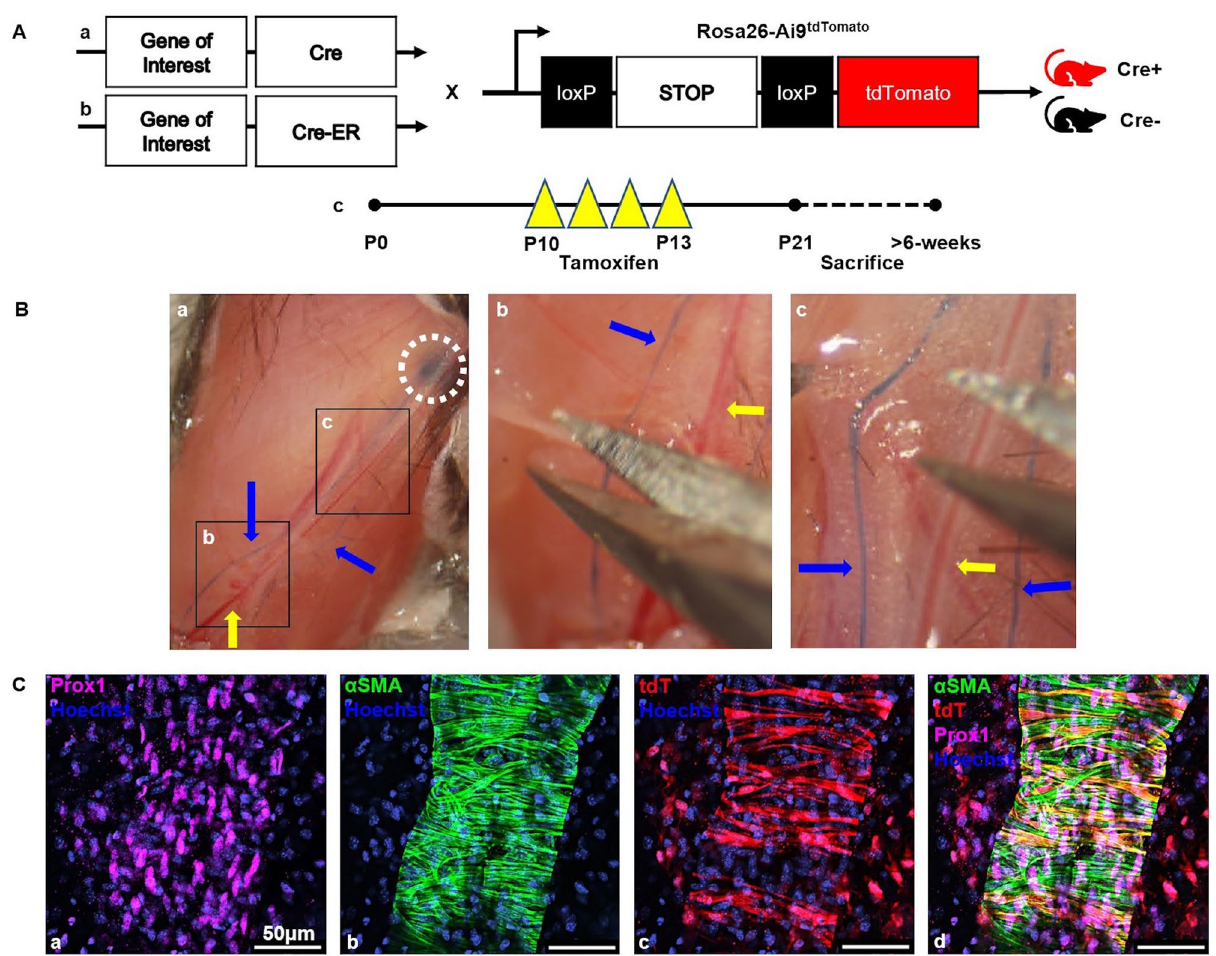
Figure 1. Genetic models for lineage tracing lymphatic muscle cells in popliteal lymphatic vessels and ex vivo whole mount multicolor fluorescent microscopy. Schematics of the constitutively-active ( A.a ) and tamoxifen- inducible ( A.b ) conditional Cre-driver constructs used in this study (Genes of Interest = Pax7, MyoD, Prrx1, and NG2) are presented with the Ai9 tdTomato reporter (tdT) construct to illustrate the heterozygous double- transgenic mice that were used in the lineage tracing (red Cre + ), and their heterozygous single-transgenic Ai9 tdTomato littermates that were used as negative controls (black Cre − ). An illustration of the tamoxifen dosing regimen (daily intraperitoneal injections on postnatal days 10–13) is also presented with the standard time of sacrifice at postnatal day 21, while all gene markers that showed PLV-LMC tdT-negativity at any time during neonatal development were additionally sacrificed > 6-weeks to validate earlier observations ( A.c ). To harvest the popliteal lymphatic vessels (PLVs), mice were anesthetized and injected with 2% Evans Blue dye (Millipore Sigma Cat# E2129) into their footpad, prior to skin removal. A 1.5 × photograph of the exposed lower limb is presented to illustrate how Evans Blue filled PLVs (two PLVs per hindlimb; blue arrows) draining into the popliteal lymph node (white circle) for PLV identification prior to excision ( B.a ). Magnified photographs of the black boxed regions illustrate incisions on the PLV border opposite the saphenous vein (yellow arrow) to release it from the fat pad ( B.b ), and then how the PLV was removed +/− the saphenous vein for analysis ( B.c ). After explant of the PLV (~ 2–3 mm in length), whole mount immunofluorescence was performed using antibodies against Prox1 with a DyLight 650-conjugated secondary antibody to mark lymphatic endothelial cells (purple) ( C.a ) and directly adjacent Alexa Fluor 488-conjugated antibodies against αSMA to mark lymphatic muscle cells (green) ( C.b ) with a Hoechst nuclear stain (blue). Direct fluorescent microscopy of the Cre-driven tdT reporter protein (red) in cells of the PLV (example of Prrx1 CreER × Ai9 tdTomato mouse) identifies positive cells in the lineage trace ( C.c ). A composite overlay of the three images is shown to illustrate co-expression of αSMA and tdT (yellow) in LMCs of Prox1 + PLVs ( C.d